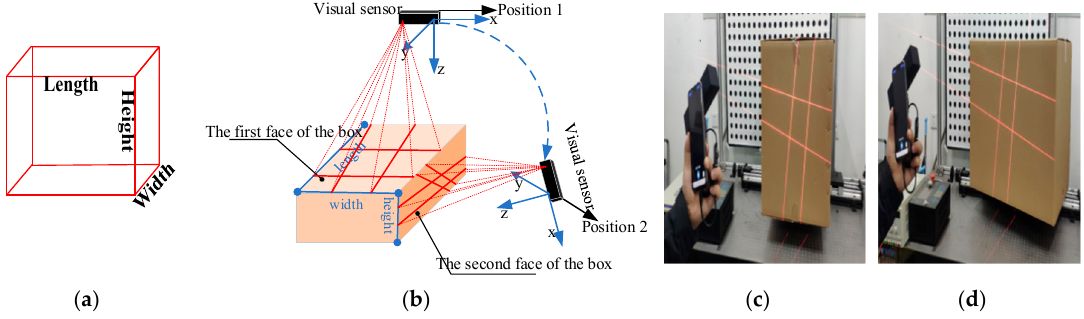
Figure 2. Schematic of the measurement system and two images captured by the system; ( a ) the box model; ( b ) the measurement method of the visual sensor and measured box; ( c ), and ( d ) the captured images for the measured box.